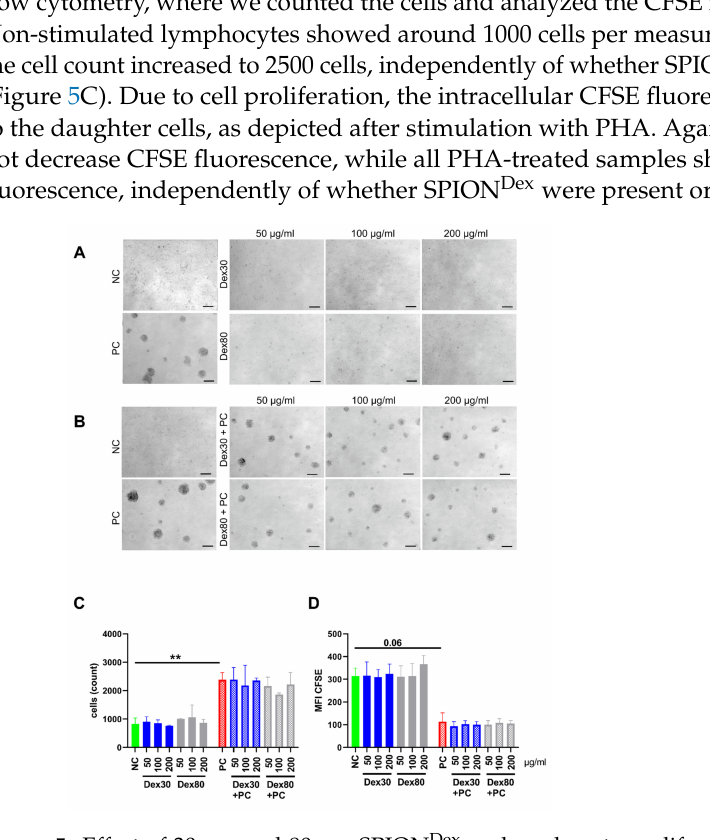
Figure 5. Effect of 30 nm and 80 nm SPION Dex on lymphocyte proliferation. Lymphocytes were incubated for 72 h with SPION Dex in the absence or presence of PHA (as the positive control, PC), activating lymphocytes. The experiment was performed with blood from three healthy donors and PBS served as a negative control (NC). Scale bar refers to 400 µ m. ( A , B ) Brightfield microscopy of ( A ) lymphocytes after 72 h incubation with SPION Dex , or ( B ) lymphocytes after 72 incubation with SPION Dex and PHA. ( C ) Flow cytometric analysis of viable cell count, ( D ) mean fluorescence index (MFI) of carboxyfluorescein succinimidyl ester (CFSE) fluorescence. The experiment was performed with blood from three donors in triplicates. The mean values with standard deviations are shown. Significance was calculated using a Kruskal–Wallis test (** p ≤